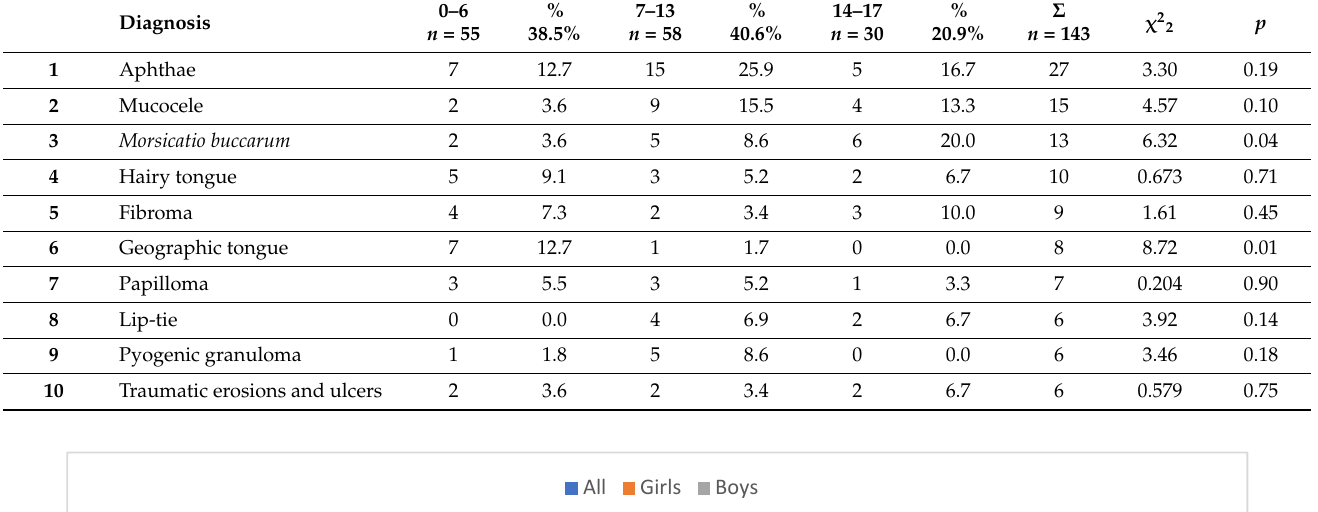
Table 4. The most frequent oral mucosa lesions (OMLs) in children in correlation with age groups.